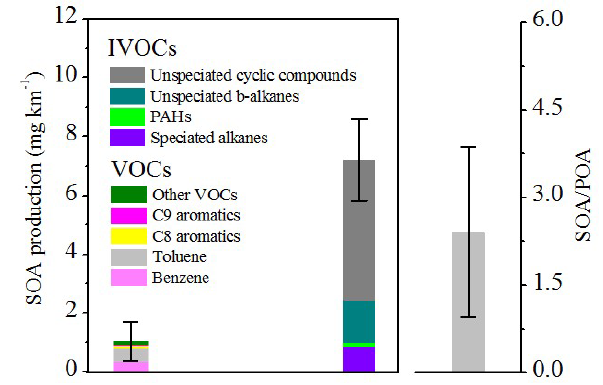
Figure 4. The predicted SOA formation potentials from different classes of precursors (VOC and IVOCs). The error bars represent 95% confidence